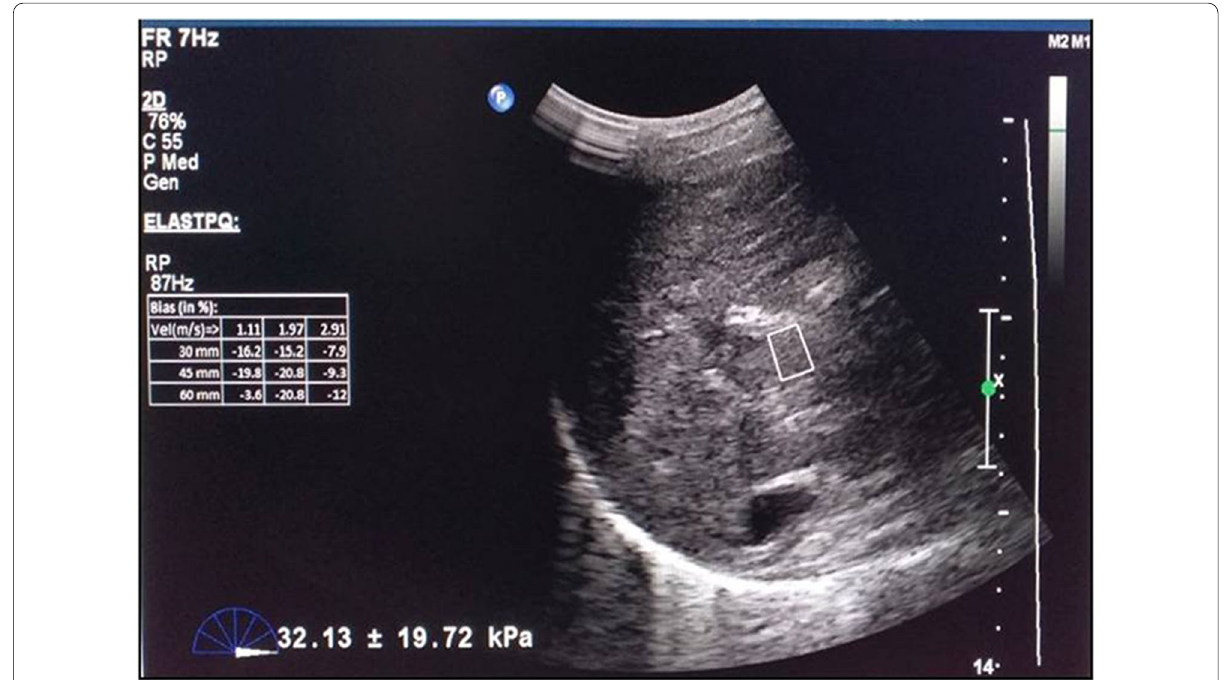
Fig. 2 p-SWE of the liver with ROI on a malignant portal vein thrombus (mean